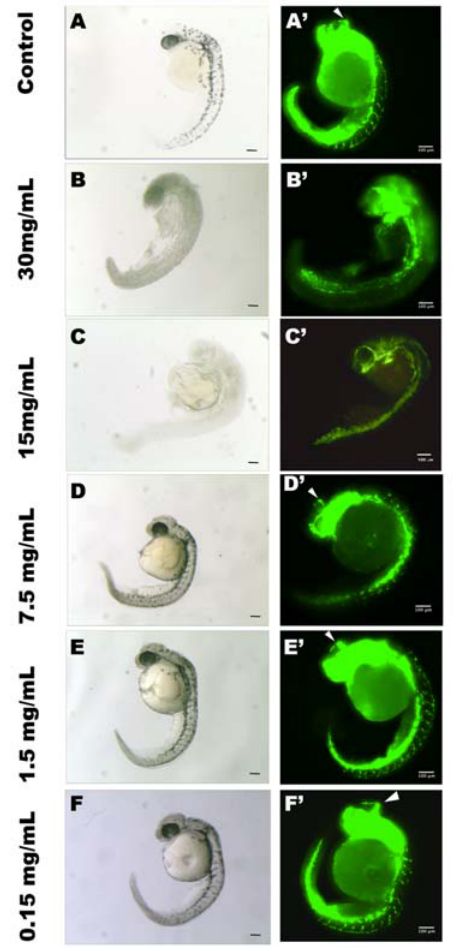
Figure 10. Zebrafish angiogenicassay. Bright-field ( A – F ) and 488 nm ( A’ – F’ ) images of 30hpf zebrafish Tg (fli1:GFP) embryos treated from 15 hpf to 30 hpf with 30 ( B , B’ ), 15 ( C , C’ ), 7.5 ( D , D’ ), 1.5 ( E , E’ ) and 0.15 ( F , F’ ) μ g·mL − 1 of GCL extract in E3 medium. Control animals were cultivated only in E3 medium ( A and A’